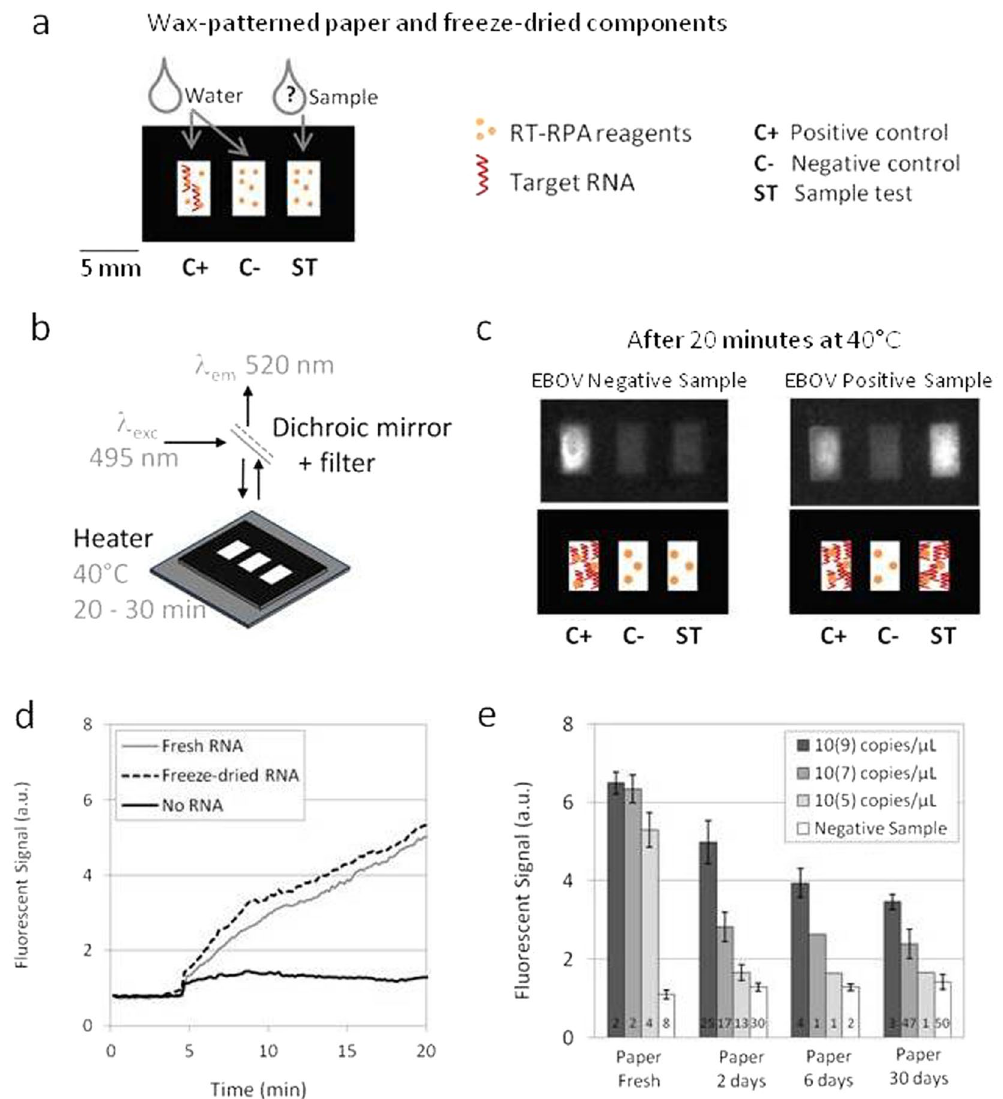
Figure 1. RT-RPA on paper. ( a ) Wax-patterned geometry on paper and location of freeze-dried RT-RPA reagents and RNA template, rehydrated either with water or the sample. ( b ) Scheme of the experimental set-up: the paper is put on a heating device and lighted with a 495 nm wavelength; the fluorescent recording at 520 nm is obtained after filtration of the emitted signal. ( c ) Pictures and scheme of typical results obtained with samples from a healthy donor and an EBOV infected patient, recorded from the experimental set-up presented in (b ) . ( d ) Fluorescent signals recording over time for freeze-dried RT-RPA reactions performed on paper and rehydrated with 2.5 µ L of distilled water (no RNA - black line), with 2.5 µ L of 10 7 copies/ µ L RNA A (fresh RNA - grey line), with 2.5 µ L of distilled water on a zone already containing the same quantities of freeze-dried RNA A (freeze-dried RNA - black dotted line). ( e ) Compared signal intensities for RT-RPA reactions performed with freshly prepared reagents on paper or with all reagents freeze-dried on paper and stored 2 days, 6 days or 30 days; with various concentrations of target RNA A (dark grey bars: 10 9 , medium grey bars: 10 7 , light grey bars: 10 5 , white bars: 0 copies/ µ